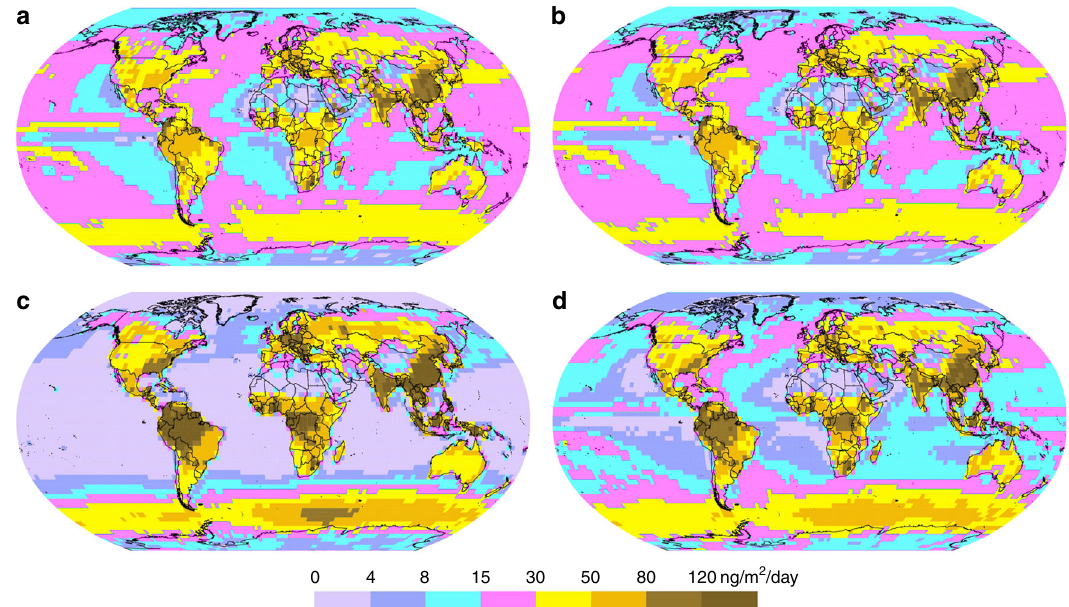
Fig. 8 Spatial distribution of total Hg (i.e. Hg(0) + Hg(II)) deposition for different tests in GLEMOS: a — Run #1; b — Run #2; c — Run #3; d — Run